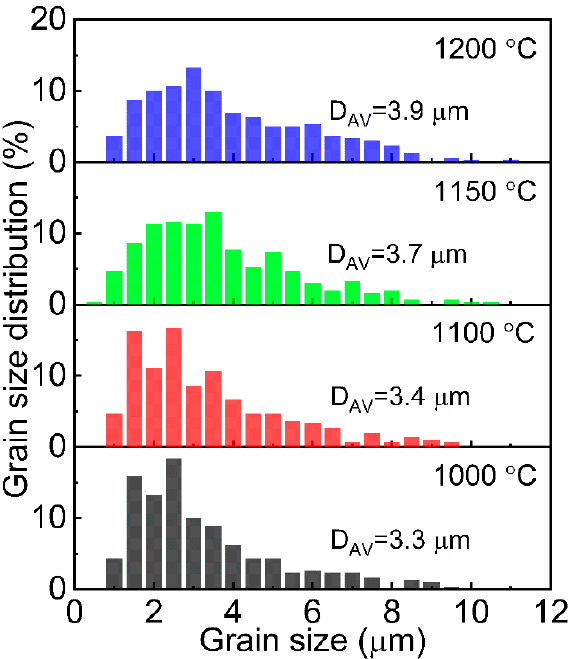
Figure 5. Grain size distribution of WC in WC-10wt%Co alloys SPSed at 1000–1200 °C.